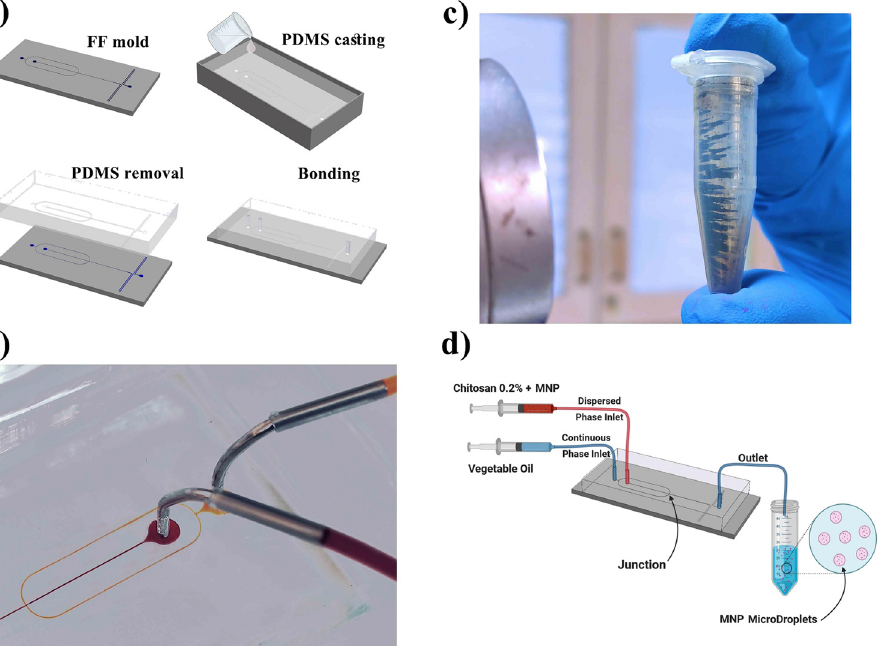
Figure 2: Design and fabrication of MFFD: ( a ) solid work schematic of the manufacturing process of MFFD; ( b ) microscopic image of MFFD with inlets, outlet, and junction; ( c ) synthesized MNP ( Fe 3 O 4 ) ; ( d ) schematic illustration of the micro fl uidic setup for producing MNP/CS nanocomposite